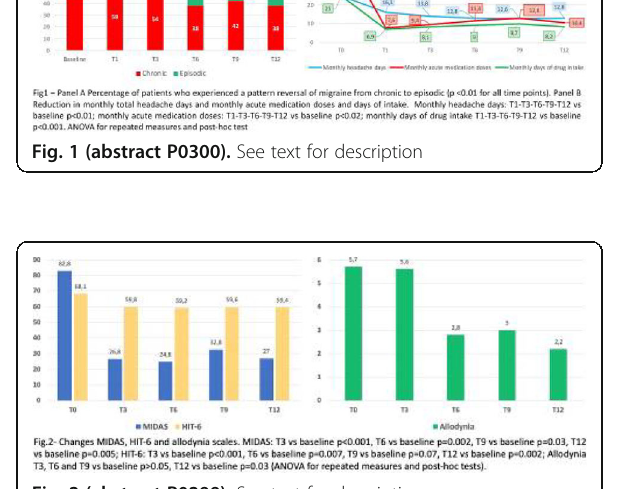
Fig. 2 (abstract P0299). See text for